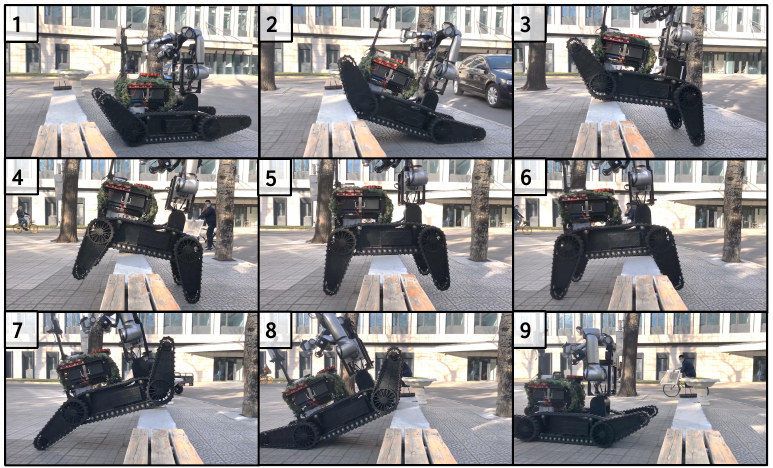
Figure 11. The 0.5-m low wall spanning experiment (details of Steps 1–9 are explained in Supplemen- tary